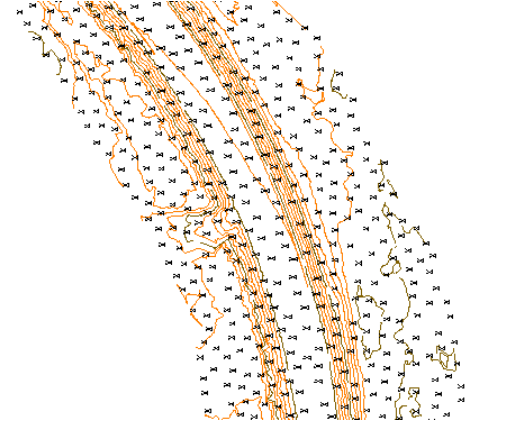
Figure 16. Angola data set area. Table 2 describes the processing time for each task of the